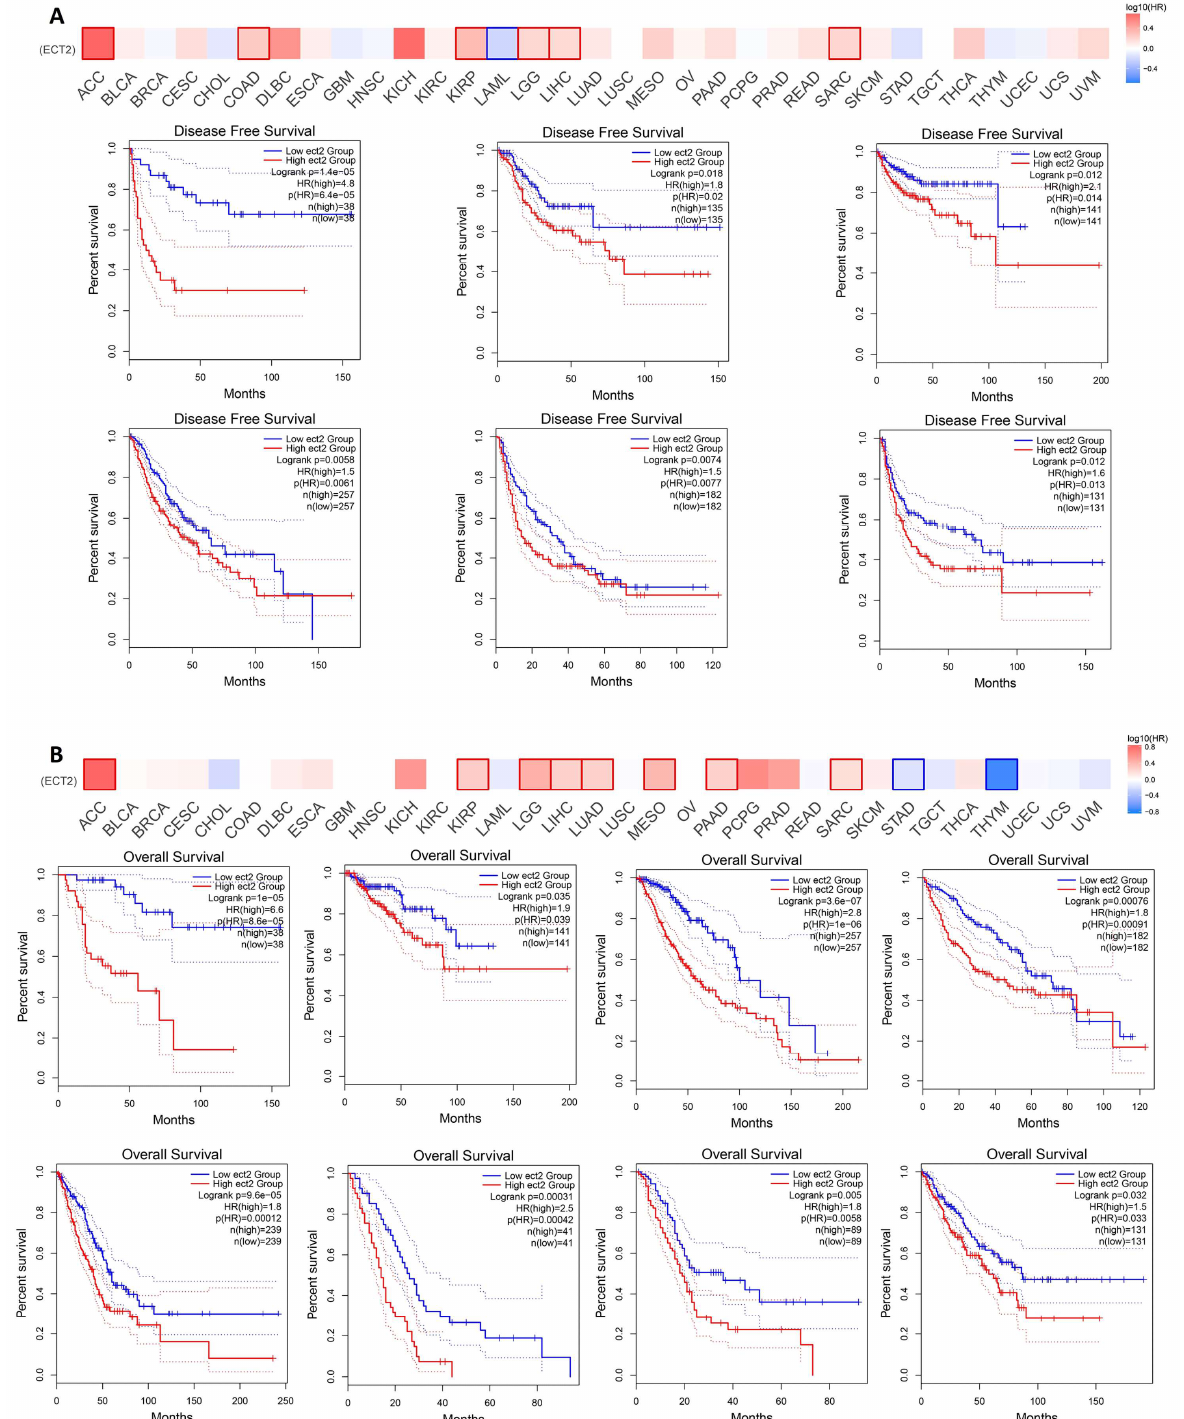
Figure 3. The correlation between ECT2 expression and the clinical outcome. ( A ) Disease-free sur- vival; ( B ) overall survival as assessed from the GEPIA2 database. Boxes represent the tumors that experienced a significant correlation.